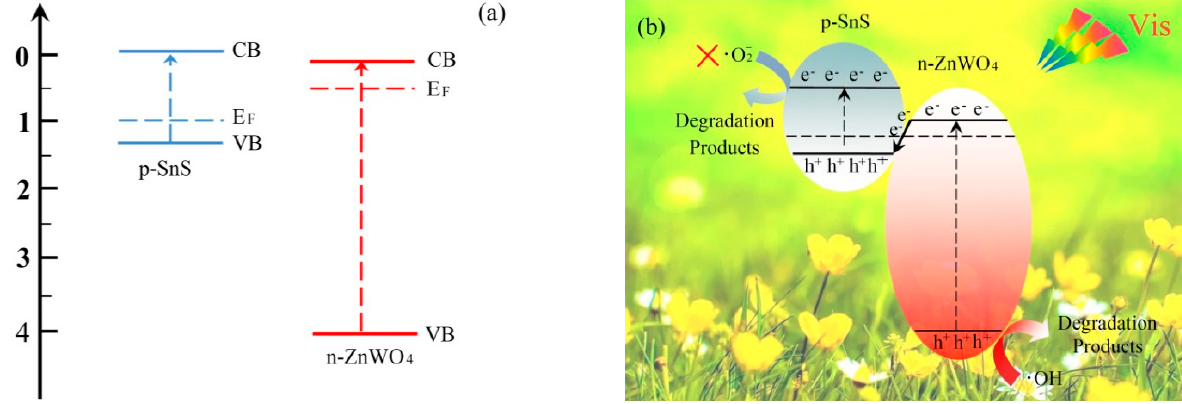
Figure 9. Schematic diagram of proposed transfer and separation pathway of photogenerated carriers over SnS/ZWO hybrid system under visible-light irradiation, ( a ) for separate phases and ( b ) after the formation of binary heterostructure.